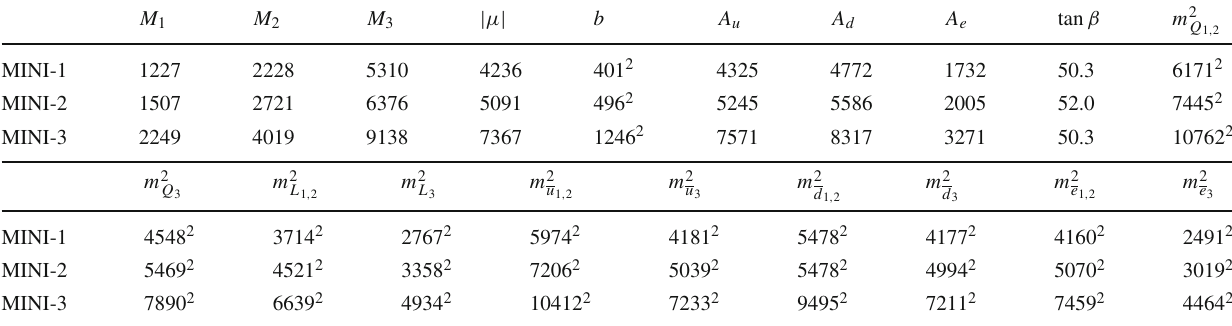
Table 1 Minimal N = 1 SU ( 5 ) predictions that are used as input to SPheno . Mass parameters are in GeV and rounded to 1 GeV